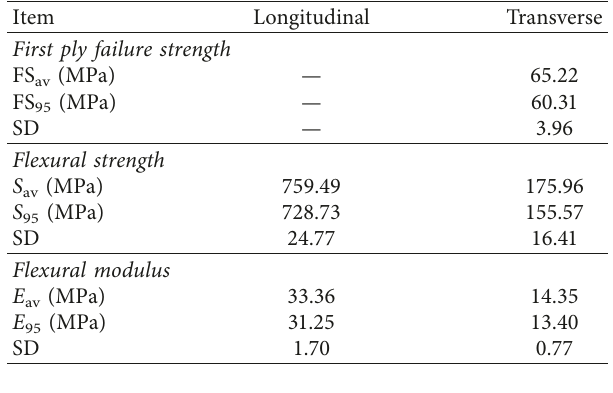
Table 3: Summary of test